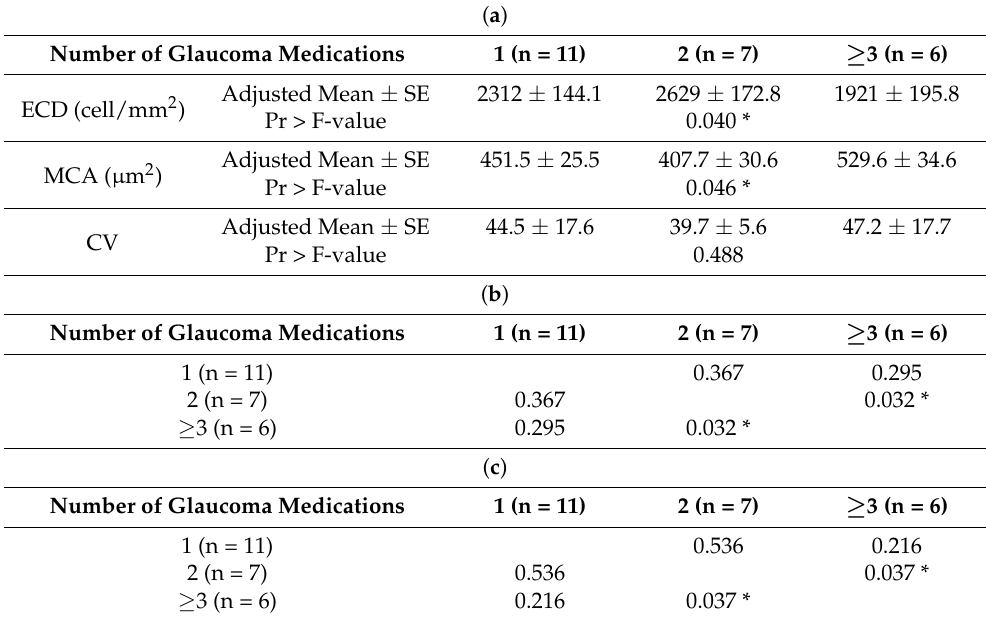
Table 5. ( a ) ANCOVA Models: ECD and MCA stratified by number of glaucoma medications adjusting for age. ( b ) p -values of least squares of ECD means for number of glaucoma medications. ( c ) p -values of least squares of MCA means for number of glaucoma medications. ( a )